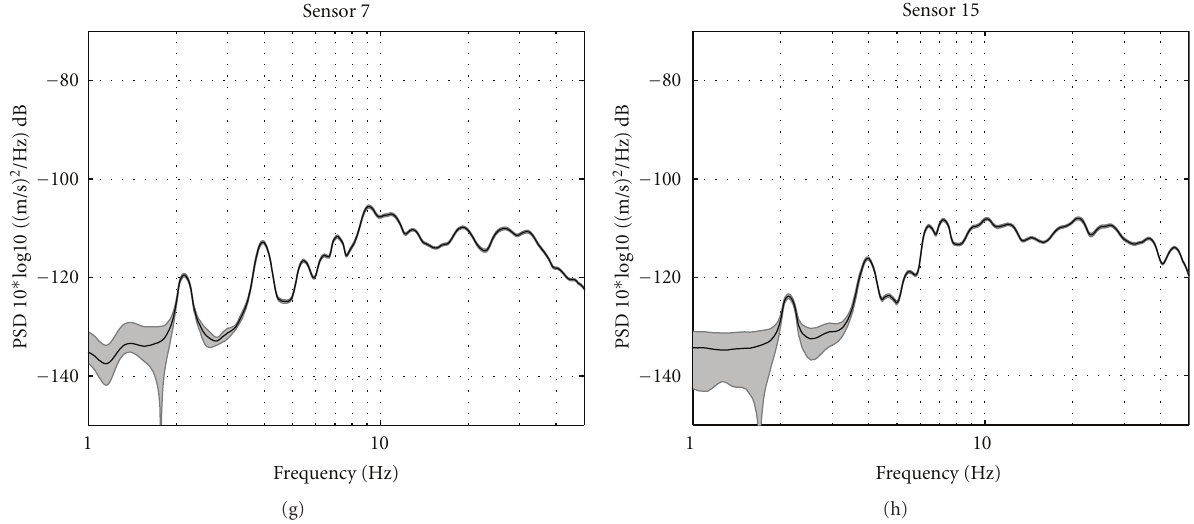
Figure 3: Fourier power spectral density (PSD) (vertical component) calculated over the time span 10:00–15:00 UTC at the 8 sensors for which time series examples have been shown in Figure 3.